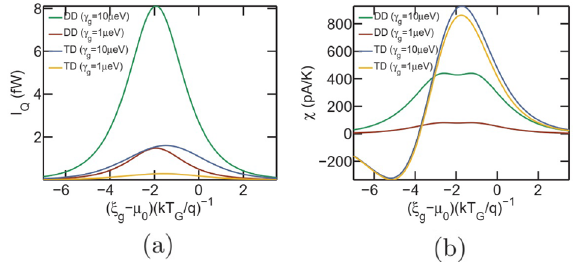
Figure 9. Analysis of thermometry induced refrigeration of the reservoir G for the dual-dot (DD) and triple dot (TD) set-up. Plot of ( a ) heat current ( I Q ) extracted from the reservoir G and ( b ) sensitivity with variation in the ground state ξ g . In case of the dual dot (DD) set-up, decreasing the system-to-reservoir coupling ( γ g ) between G and G 1 decreases both the extracted heat current I Q and sensitivity χ . However, for the triple dot set-up, decreasing γ g suppresses only the heat current I Q , while keeping the sensitivity ( χ ) almost unaltered. The parameters used for simulation are U m = 100 µ eV, γ c = 10 µ eV, T L ( R ) = T G = 300 mK and ξ 1 s = µ 0